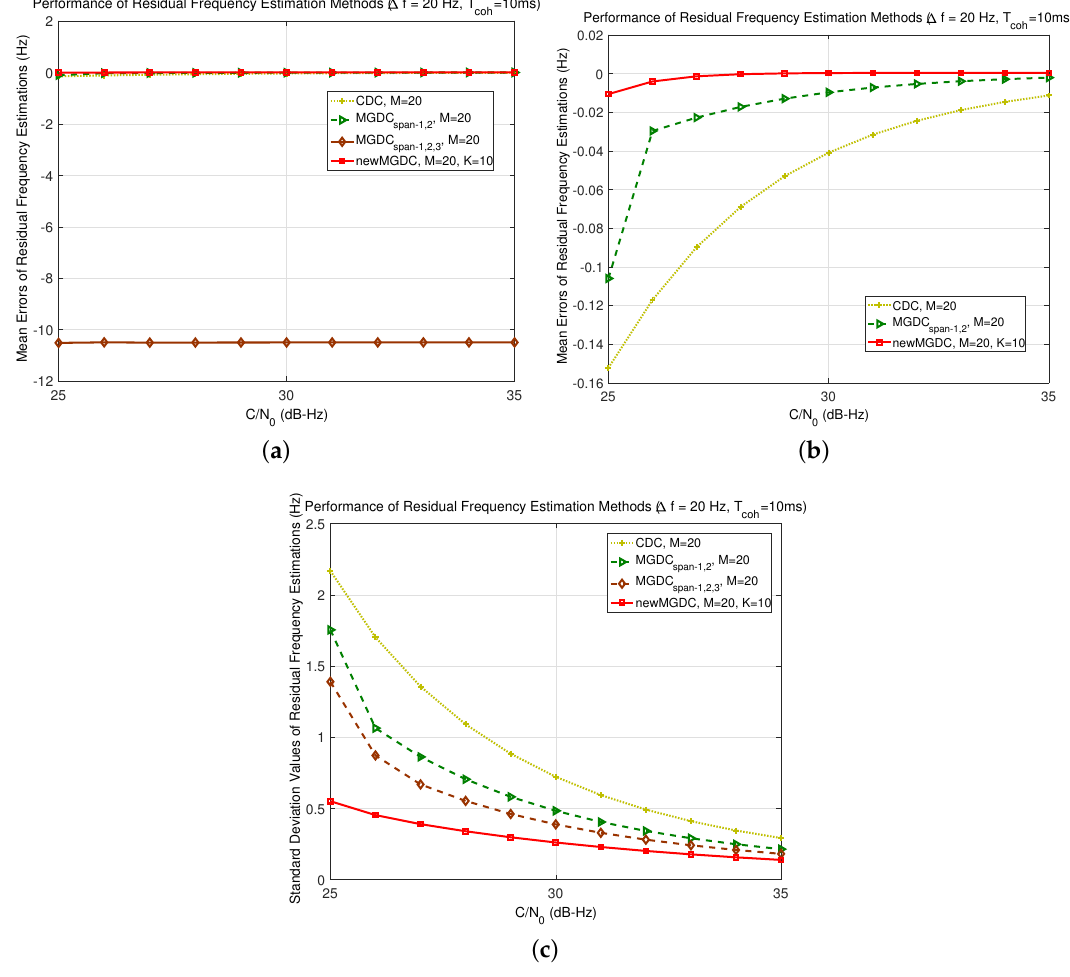
= 20 Hz, T = 10 ms, coh d